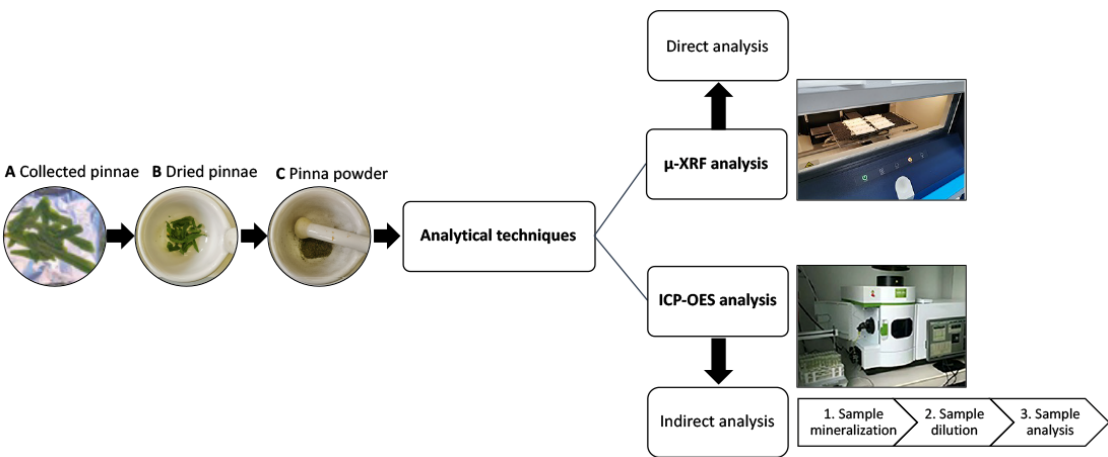
Figure 8. Flowchart demonstrating technical steps used in the approaches of µXRF and ICP–OES analyses.